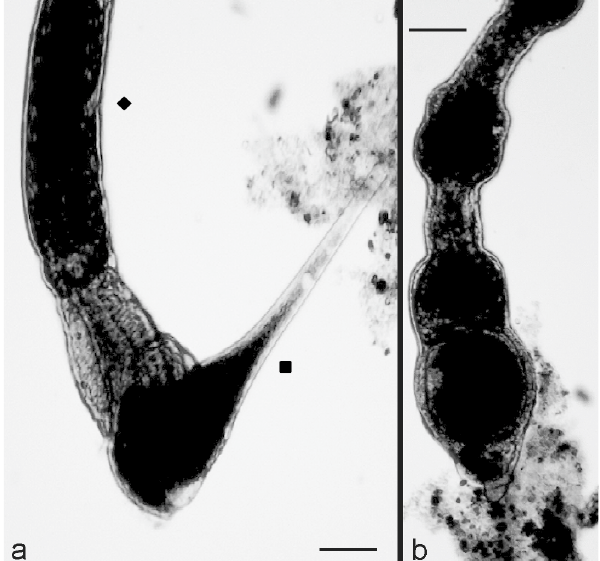
Figure 5. The predator-prey interaction between S. sphagnetorum ( (cid:117) ) and the extrusome-deficient cells of S. polymorphus ( (cid:4) ). ( a ) the predator contacts an extrusome-deficient cell of S. polymorphus. ( b ) after a quick contraction, the prey is completely engulfed by the predator. Photomicrographs obtained from a film clip. Scale bar = 100 µ